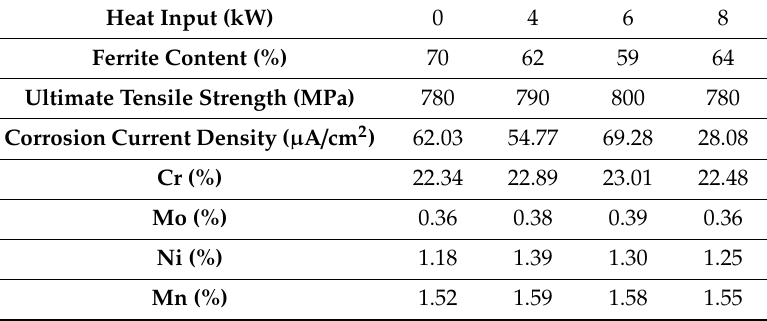
Table 14. Properties, ferrite and phase stabilizers composition of duplex stainless steel at di ff erent heat inputs